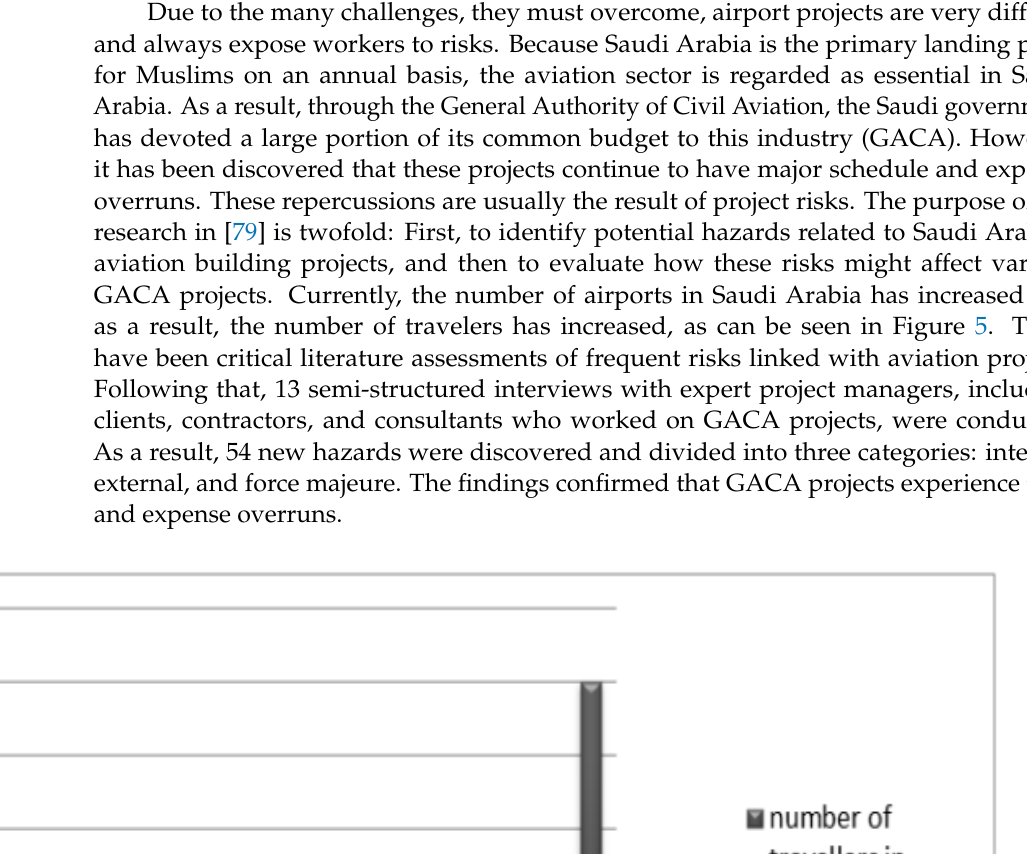
different construction industries in Saudi